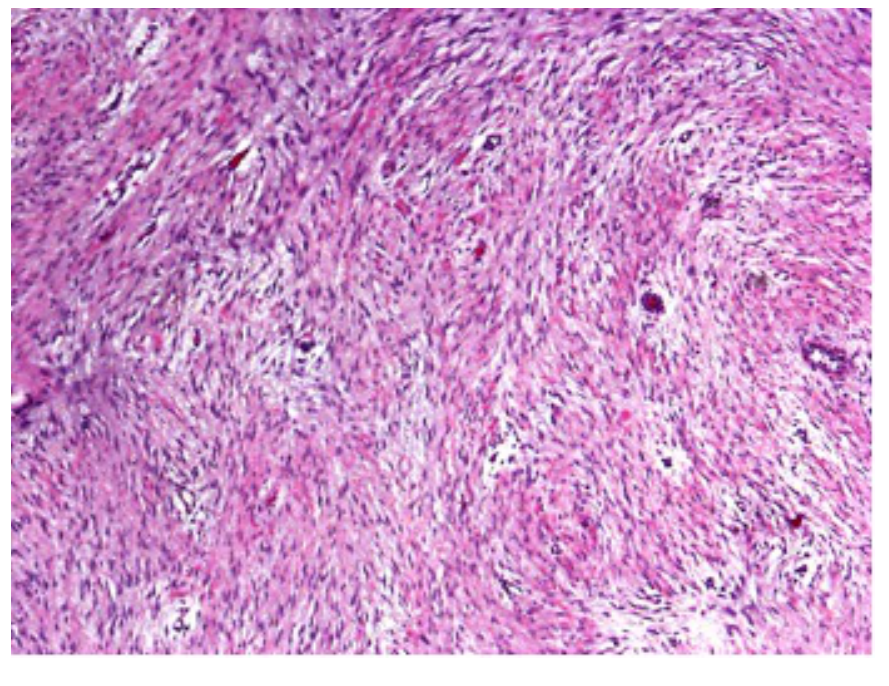
Figure 1. The microscopic appearance of a desmoid tumor reveals well-differentiated cells and bands of fibrous